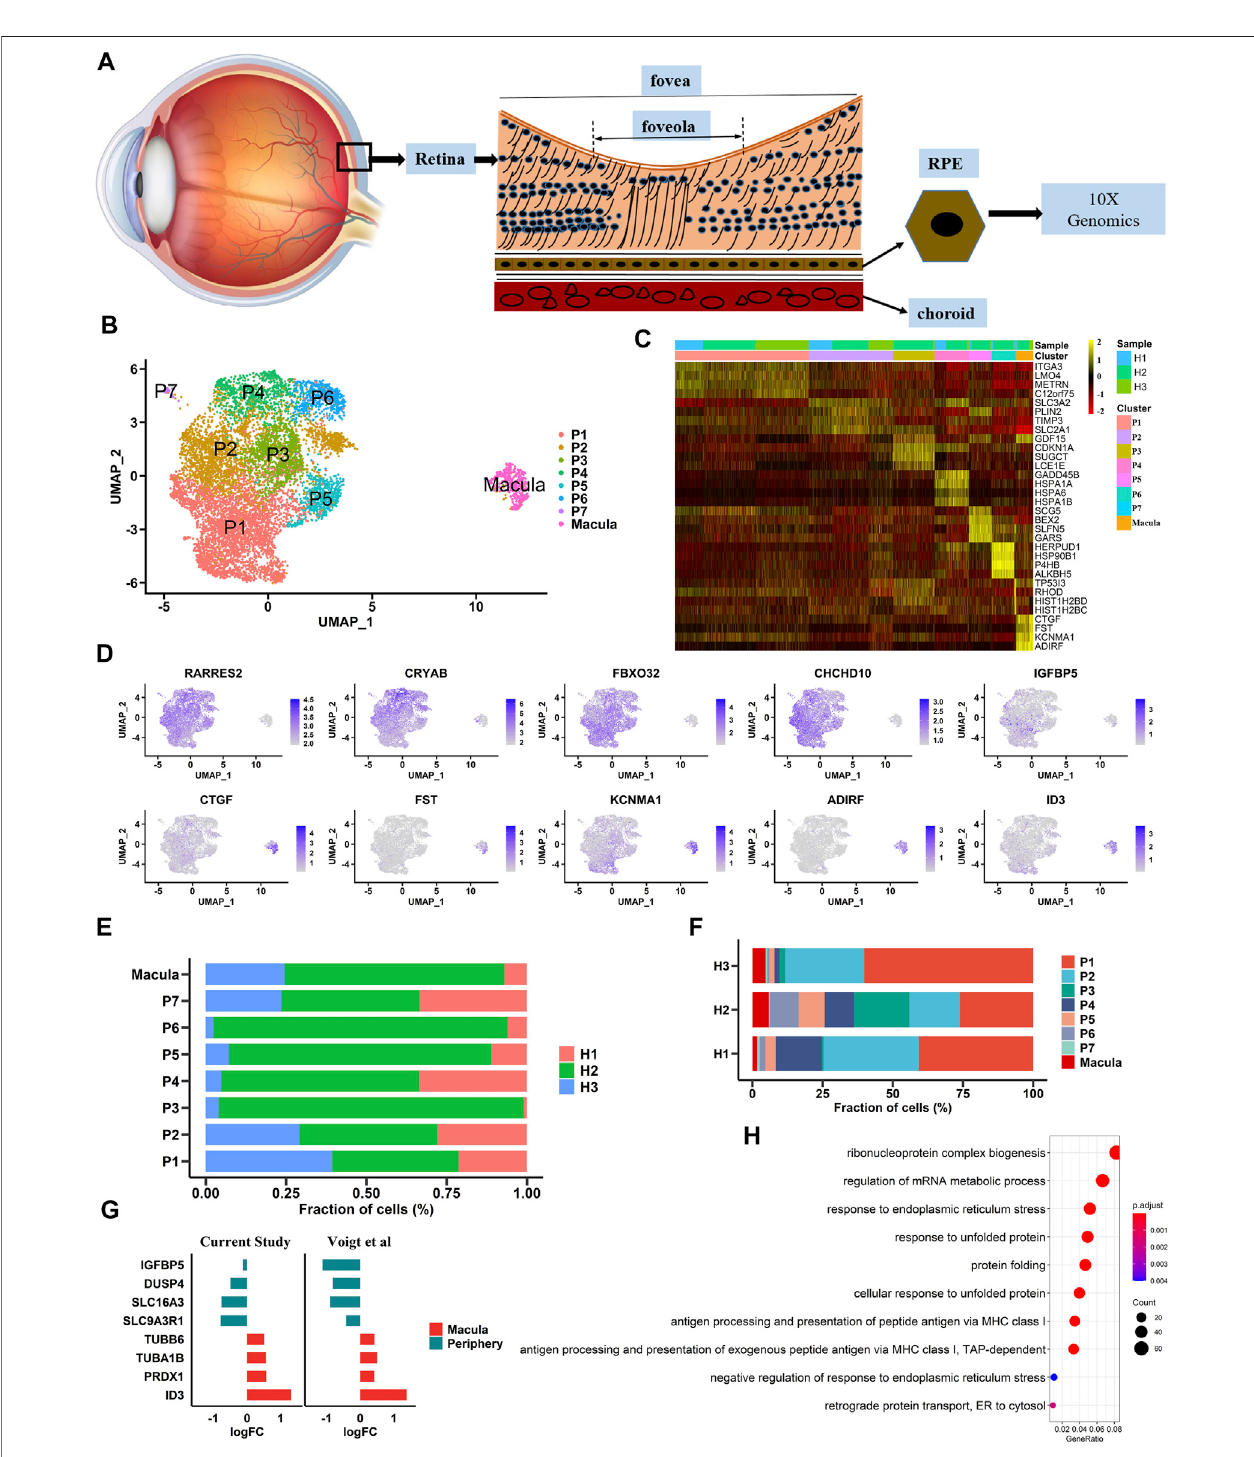
FIGURE1| Single-cellRNA-seq transcriptomepro fi lingofhRPE (A). Aschematic diagram oftheextracted samplecells isshown.Single cellswereextracted from human RPE tissue to complete next-generation sequencing (B) . Identi fi cation of cell populations. UMAP projection of 9,302 single cells from three samples showed a totalofeightcelltypepopulations.Eachpointisacell,anddifferentcelltypesaredifferentiatedbydifferentcolors (C) .Heatmapsofcelltypes.Columnsrepresentgroups of cells, and rows represent speci fi c, highly expressed differentially expressed genes for each cell type. The heatmap scale represents the normalized expression value (D) .DifferentialgeneexpressioninlargeandsmallclustersisshownintheUMAPplot (E) .Theproportionofeachsampleineachcluster (F) .Theproportionofeach cluster in each sample (G) . The expression patterns of differential genes in our data were consistent with those in previous studies (H) . Gene Ontology (GO) terms associated with genes with upregulated expression in the macula cluster.